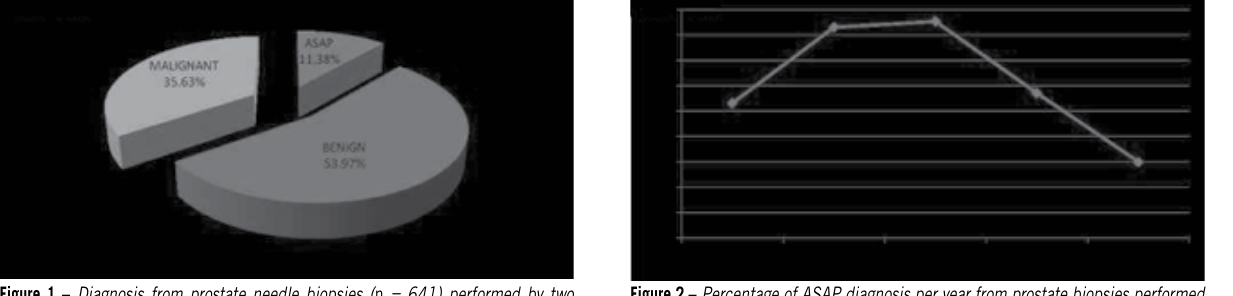
Figure 1 – Diagnosis from prostate needle biopsies ( n = 641) performed by two laboratories of surgical pathology over a period of five consecutive years ASAP: atypical small acinar proliferation.